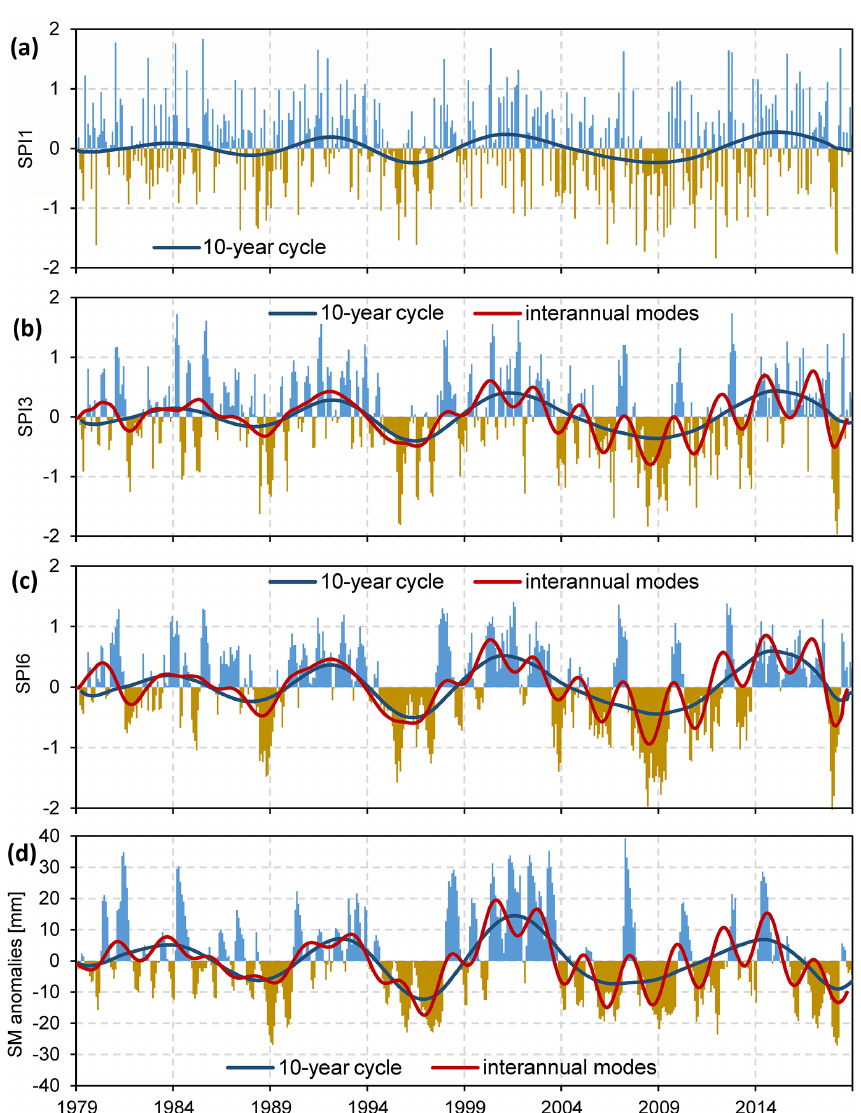
Figure 4. Areal-averaged time series from January 1979 to December 2018 for (a) SPI1, (b) SPI3, (c) SPI6, and (d) soil moisture anomalies in the core crop region. The dominant modes of interannual variability are plotted in solid